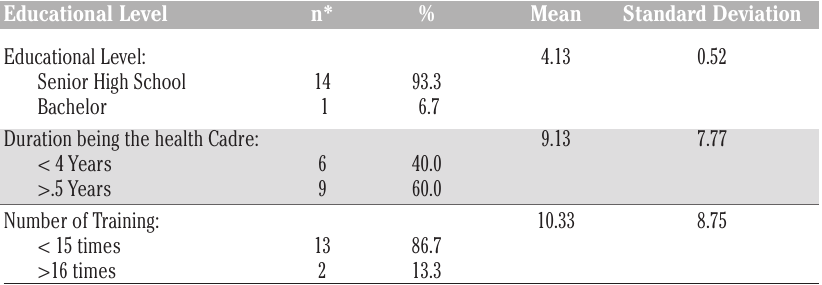
Table 1. Distribution of characteristic of cadre’s capacity who involves in fast food control in Mokoau Health Care Centre Area in 2019.